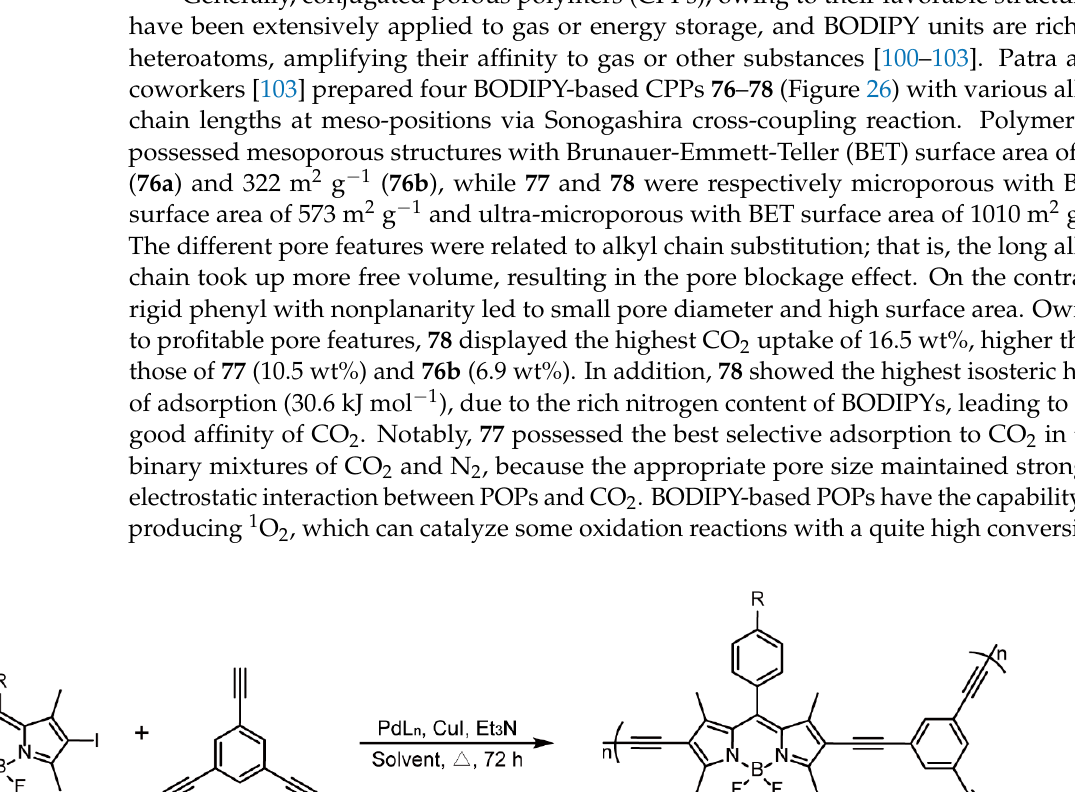
Figure 25. Chemical structures of polymers 73–75 [98] (Reproduced with permission from Reference [96]. Copyright @ 2016, Royal Society of Chemistry).